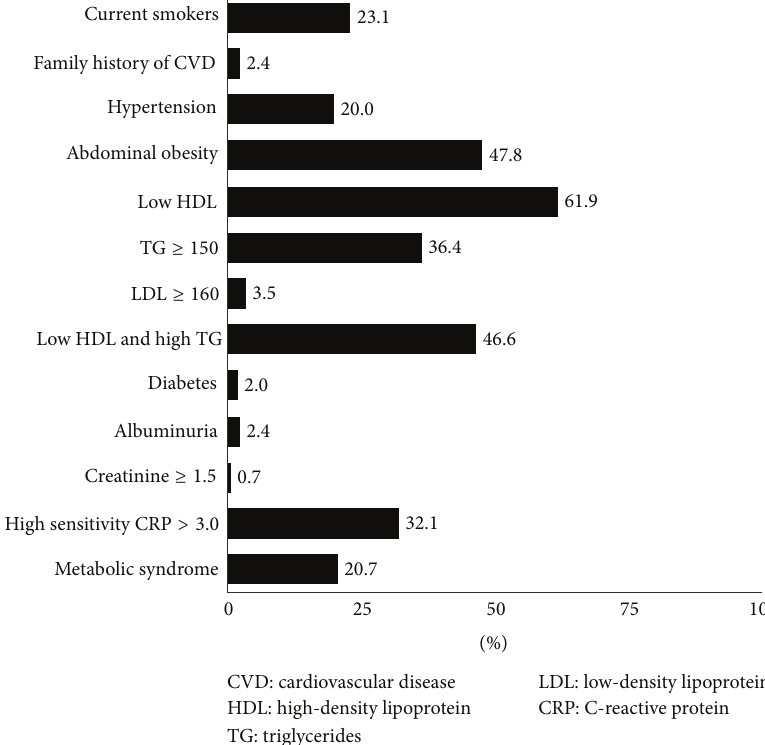
Figure 1: Prevalence of cardiovascular risk factors among 294 HIV-infected